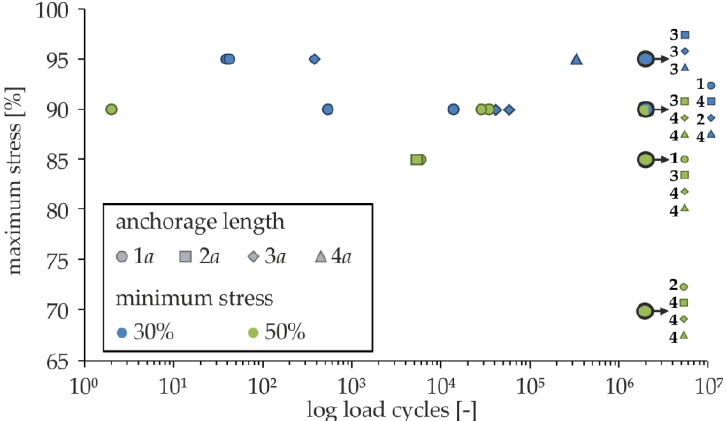
Figure 13. S-N diagram with relative maximum stresses for DPO tests with di ff erent anchorage lengths and two di ff erent minimum stresses.